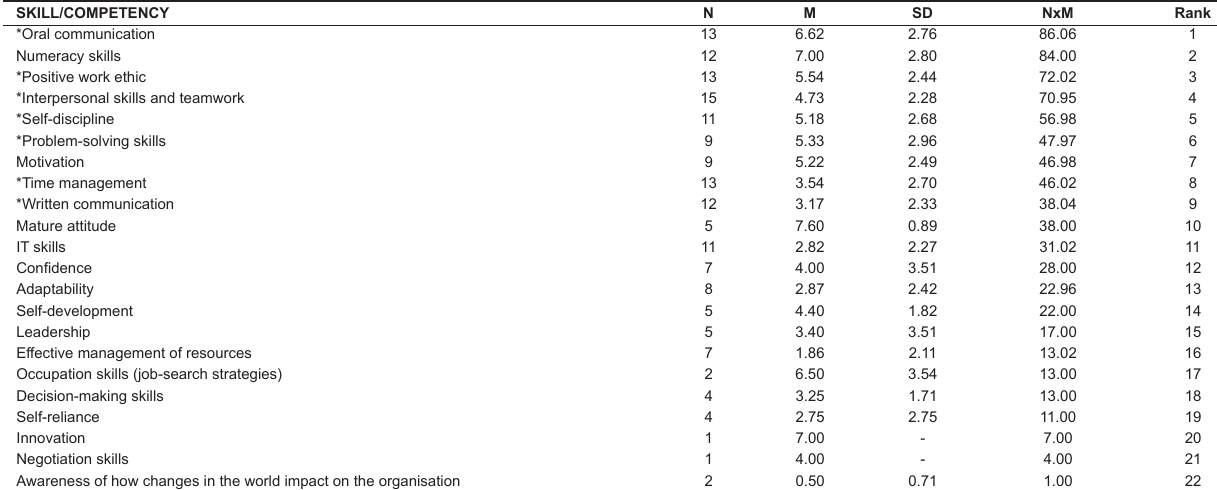
TABLE 6 descriptive statistics and ranking of skills/competencies by